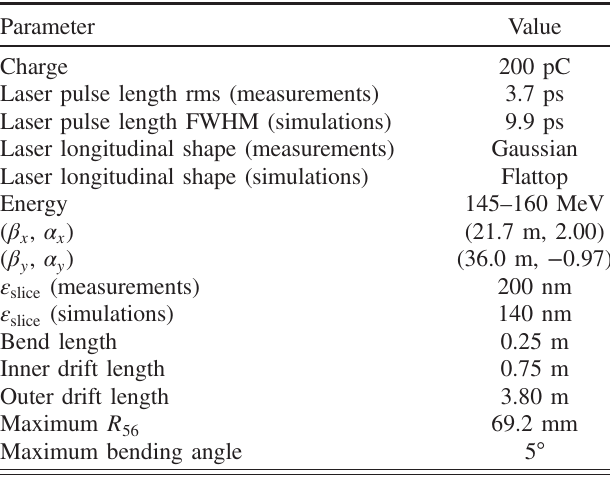
TABLE II. Beam parameters at the bunch compressor entrance and compressor settings at the SITF for the measurements and the supporting simulations. The subscripts x and y refer to horizontal and vertical, respectively.